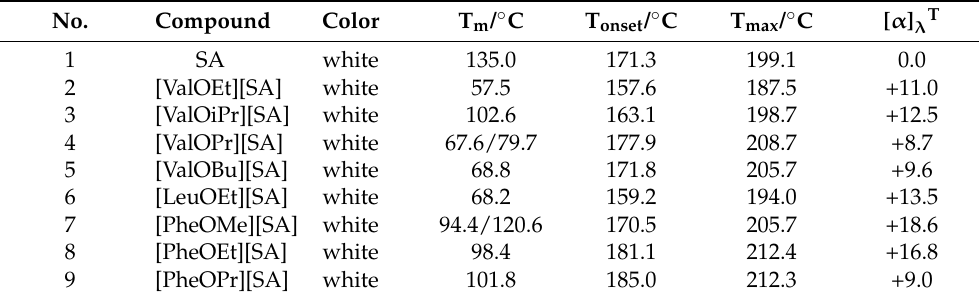
Table 1. The properties of salicylic acid and amino acids alkyl esters salicylates.